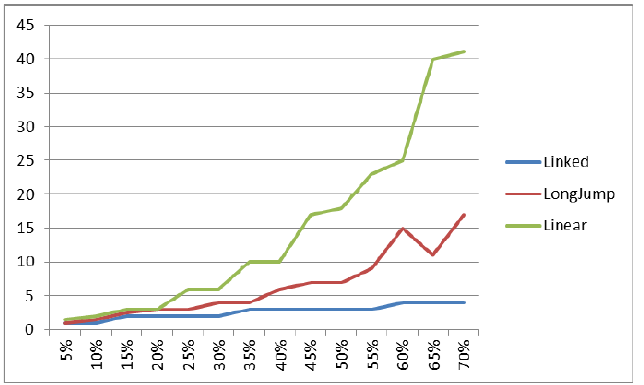
Fig. 5. Average max conflict for Murmur, size=6,151 1